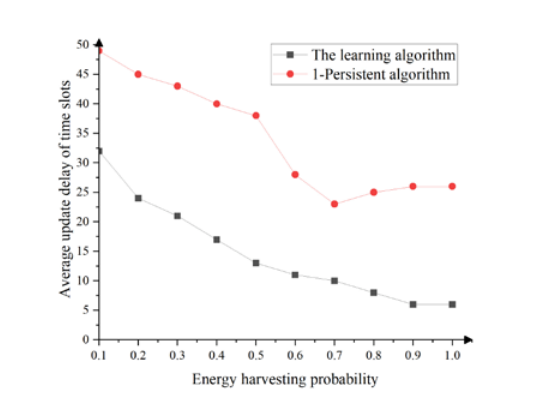
Fig. 3. The average update delay of time slots of the ST under various energy harvesting probability